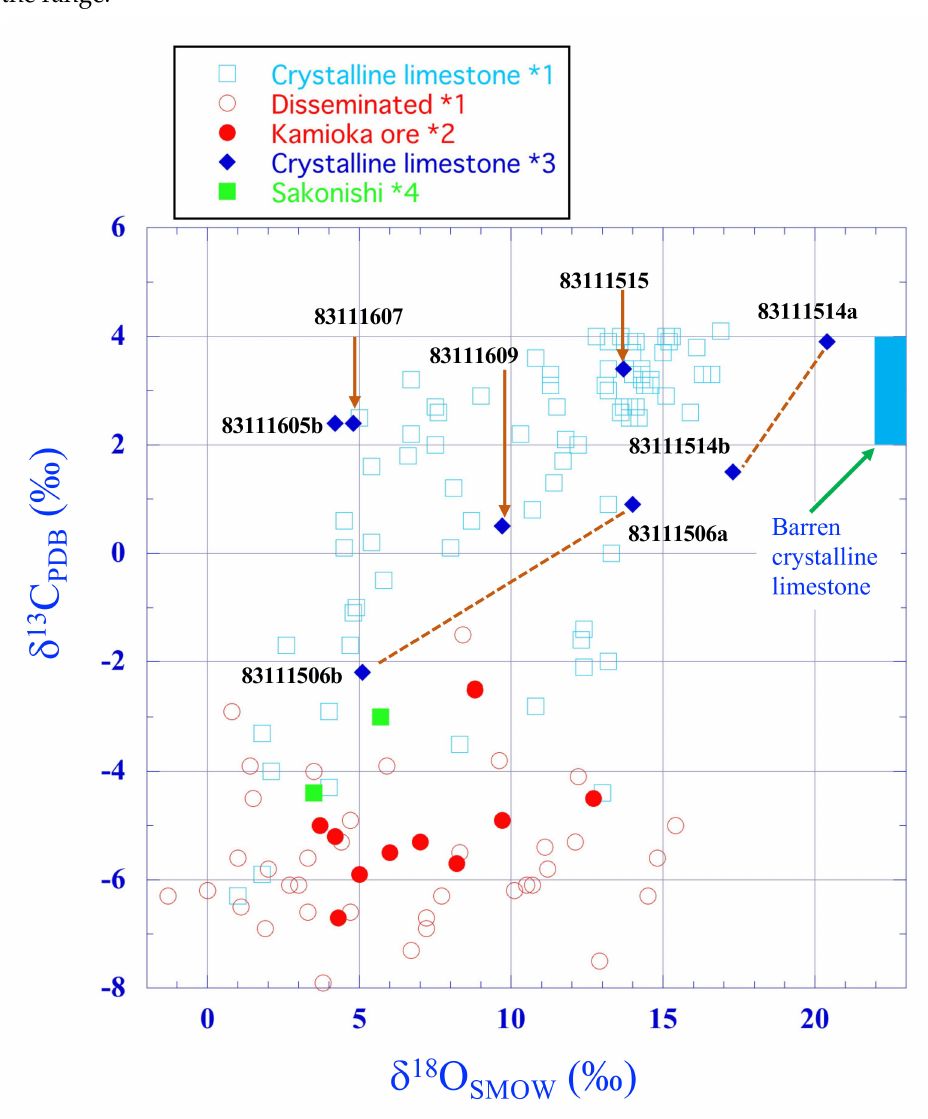
Figure 5. The δ 13 C and δ 18 O values of the calcite obtained in this study are superimposed on Figure 4. Crystalline limestone *1 and disseminated *1 calcites (both are represented by open symbols) are from the Sakonishi area [2]. Kamioka ore *2 and the crystalline limestone *3 samples are from the Tochibora, Maruyama, or Mozumi deposits, and the Sakonishi *4 samples are from the Sakonishi area. The square box indicates the range of the δ 13 C and δ 18 O values of the barren crystalline limestone. Note that the sample numbers in the figure are for crystalline limestone *3 samples and all solid symbols represent new data obtained in this